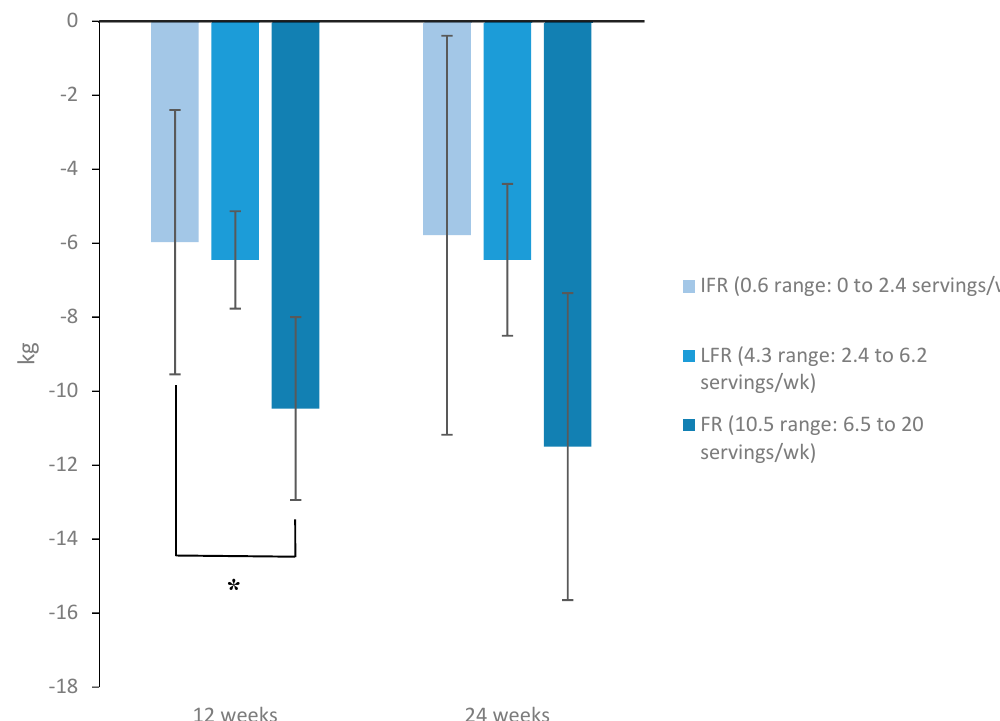
Figure 3. Changes in body weight at the end of the intervention phase (12 weeks) and the end of the maintenance phase (24 weeks) among female subjects stratified by dairy consumption. Female subjects who consumed, on average, 10.5 (6.5 to 20) servings / wk of dairy products ( n = 7) during the IMWM program achieved a significantly higher amount of weight loss at 12 weeks compared with peers who consumed, on average, 0.6 (0 to 2.4) servings / wk ( n = 7). * p = 0.027 for FR vs. IFR. Analyses were done using one-way ANOVA followed by Bonferroni correction for multiple comparisons. These di ff erences remained significant after adjusting for baseline body weight, TEI, fat mass, and age. At 24 weeks, there was no significant di ff erence in body weight change between tertiles. Data are mean ± SEM. Abbreviations: FR, frequent dairy consumers; LFR, less-frequent dairy consumers; IFR, infrequent dairy